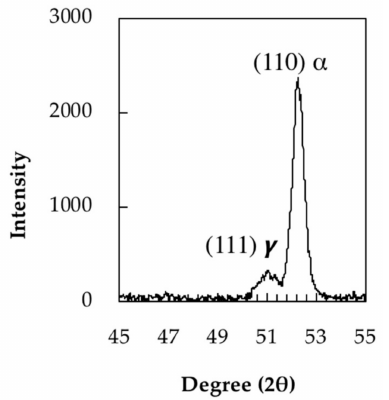
Figure 4. XRD (111) peak of retained